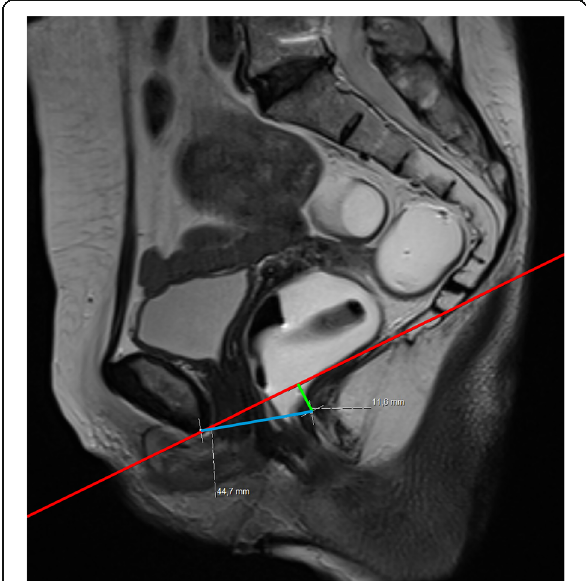
Fig. 7 Normal H and M lines. Sagittal midline T2-TSE image demonstrating the normal measurements of the H (4.47 cm) and M (1.16 cm) lines. Red line : PCL; blue line : H line; green line : M line